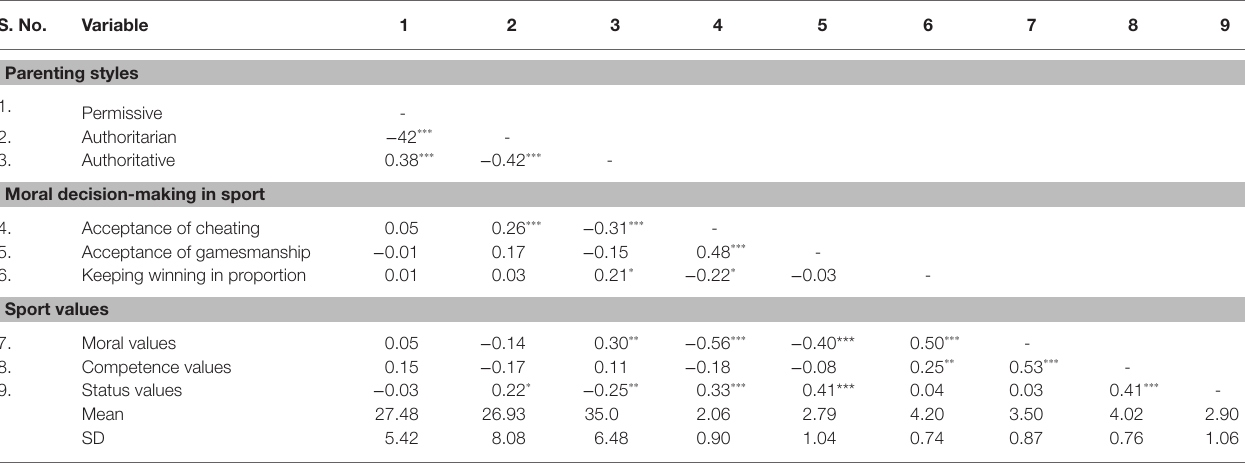
TABLE 1 | Descriptive statistics and correlation matrix for the research variables. S.